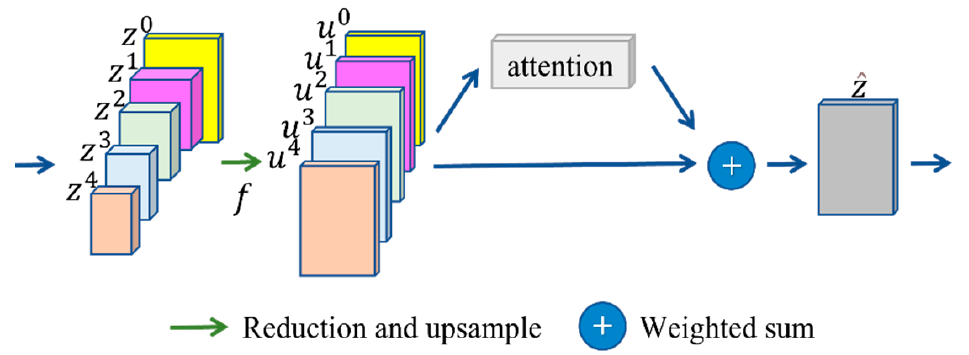
Figure 3. Feature pyramid network structure.